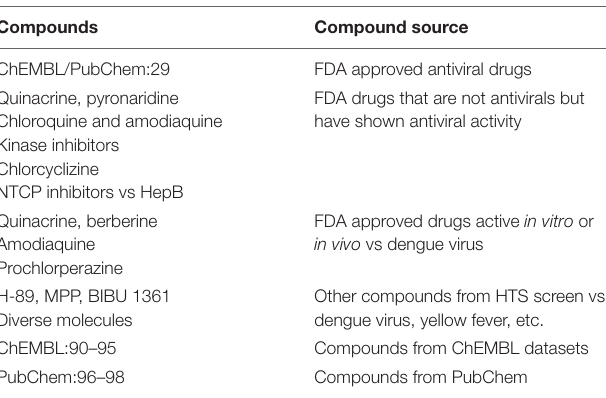
TABLE 2 | The potential drug candidates suggested being ideal toward ZIKV and these probably provide insights in future vaccine